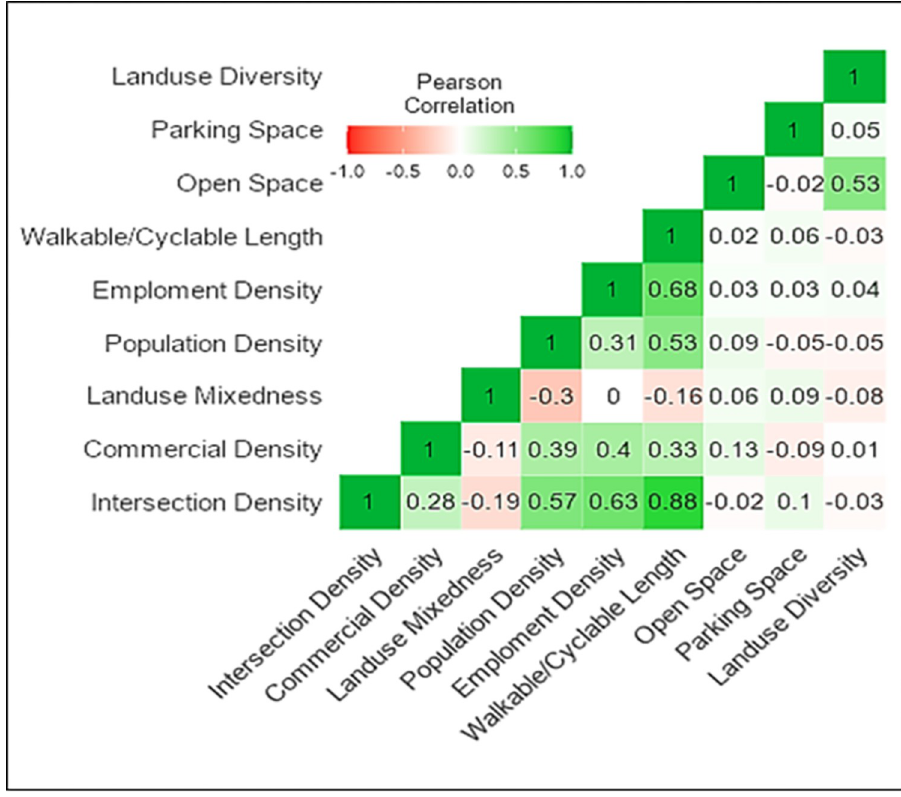
Fig 6. Correlation heatmap of